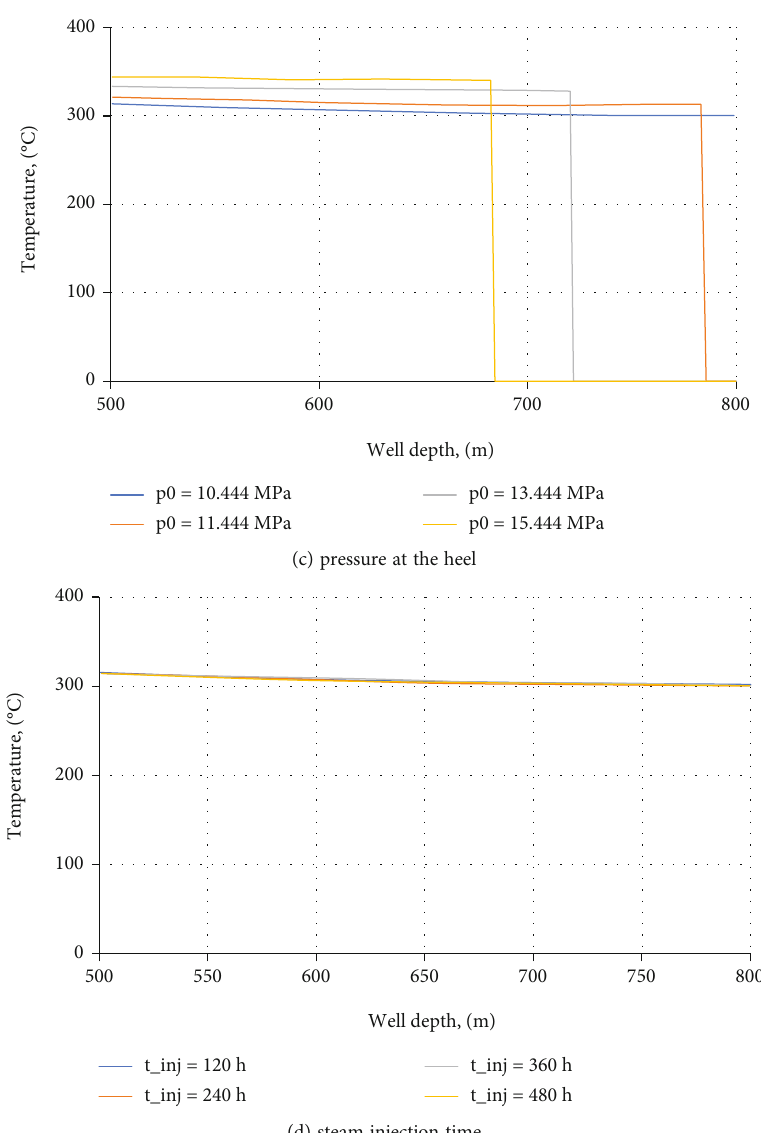
Figure 10: E ff ect of (a) steam injection rate, (b) steam quality at the heel, (c) pressure at the heel and (d) steam injection time on the distribution of temperature along the